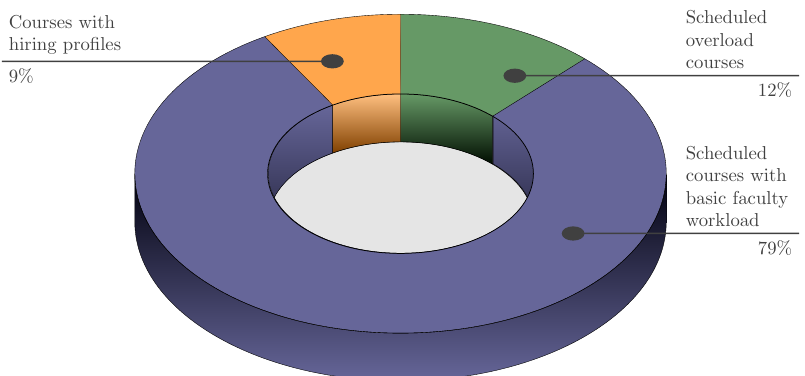
Figure 3. Proportions of